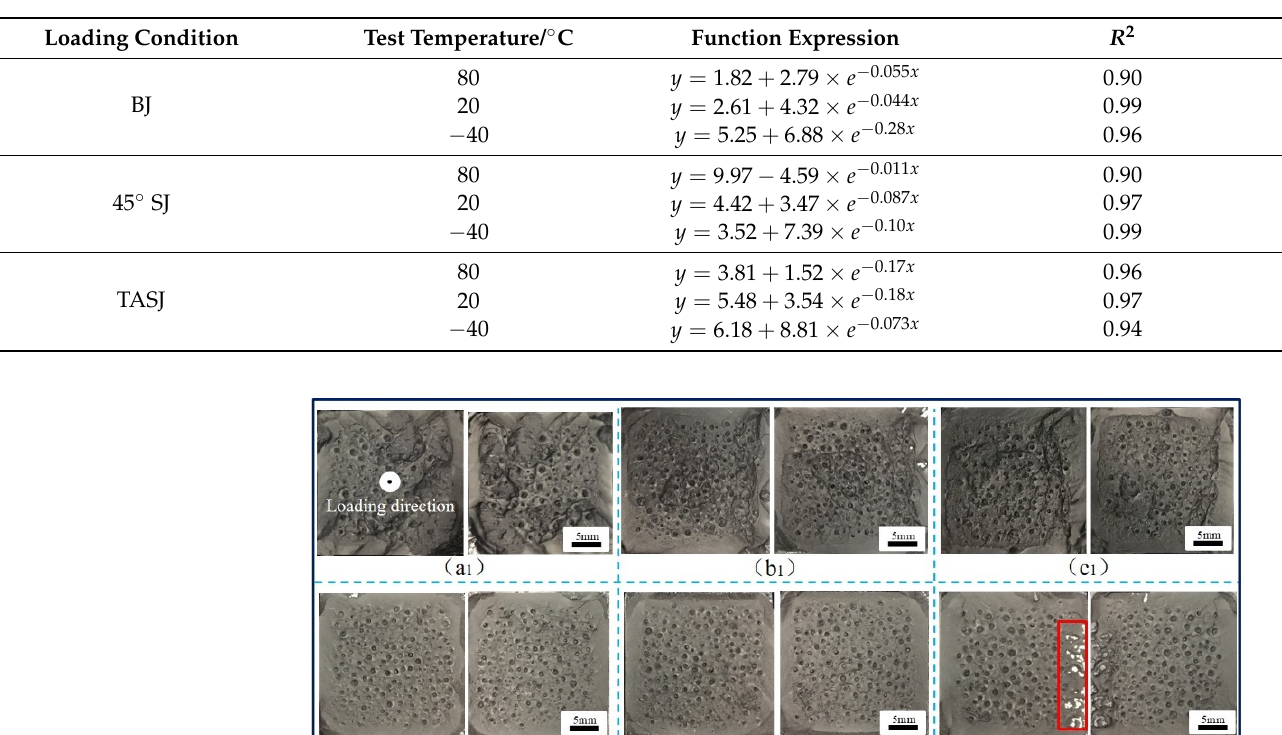
Table 3. Fitting function expressions and fitting accuracy R 2 .